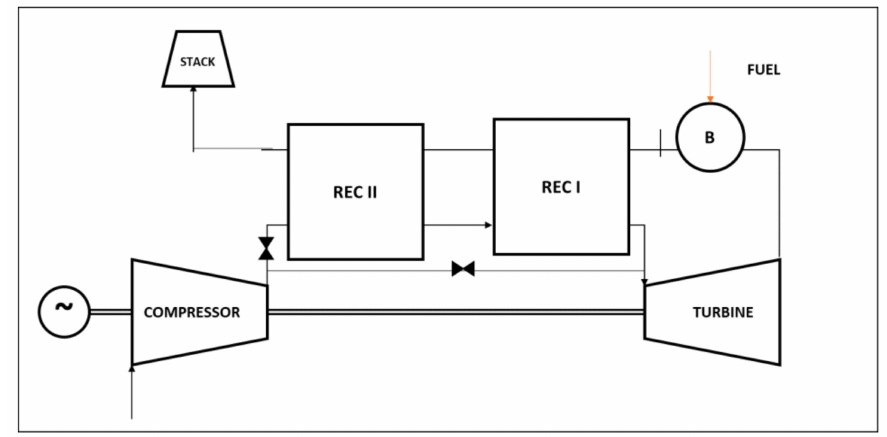
Figure 7. Externally fired micro gas turbine with two recuperators [39].